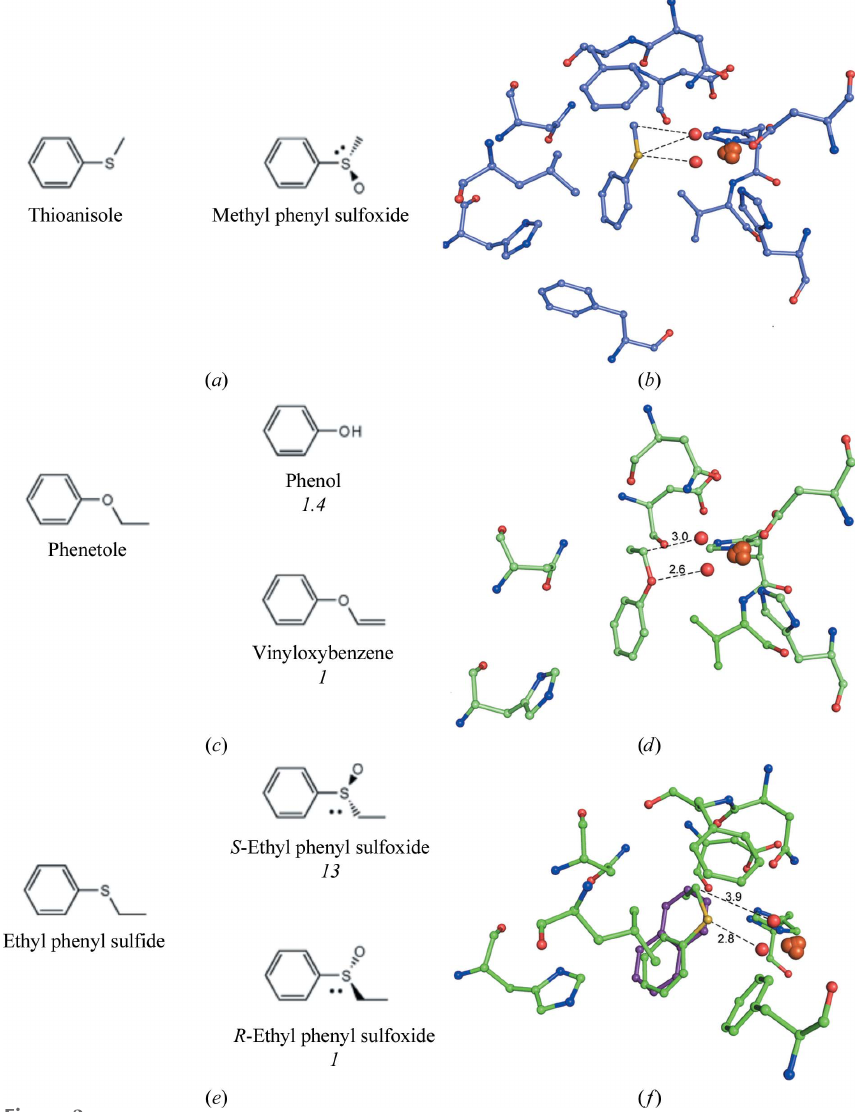
Figure 3 Products formed by NDO with thioanisole ( a ), phenetole ( c ) and ethylphenylsulfide ( e ). Approximate ratios of products detected in biotransformation assays are shown in italics below the products. Wild-type NDO in complex with phenetole (green) ( d ), with ethylphenylsulfide (green) overlapped with that with naphthalene (purple) ( f ) and with thioanisole (green) ( b ), with active-site residues of NDO represented by sticks with green C atoms. The mononuclear iron (large orange sphere) and modeled dioxygen from PDB entry 1o7n (small red spheres) are also